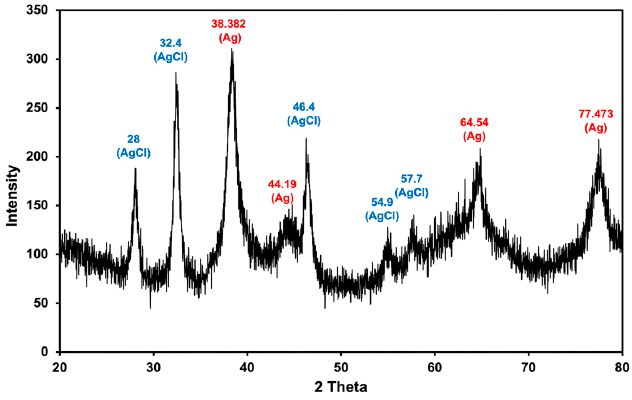
Figure 4. XRD spectra of biosynthesized MLE-AgNPs.